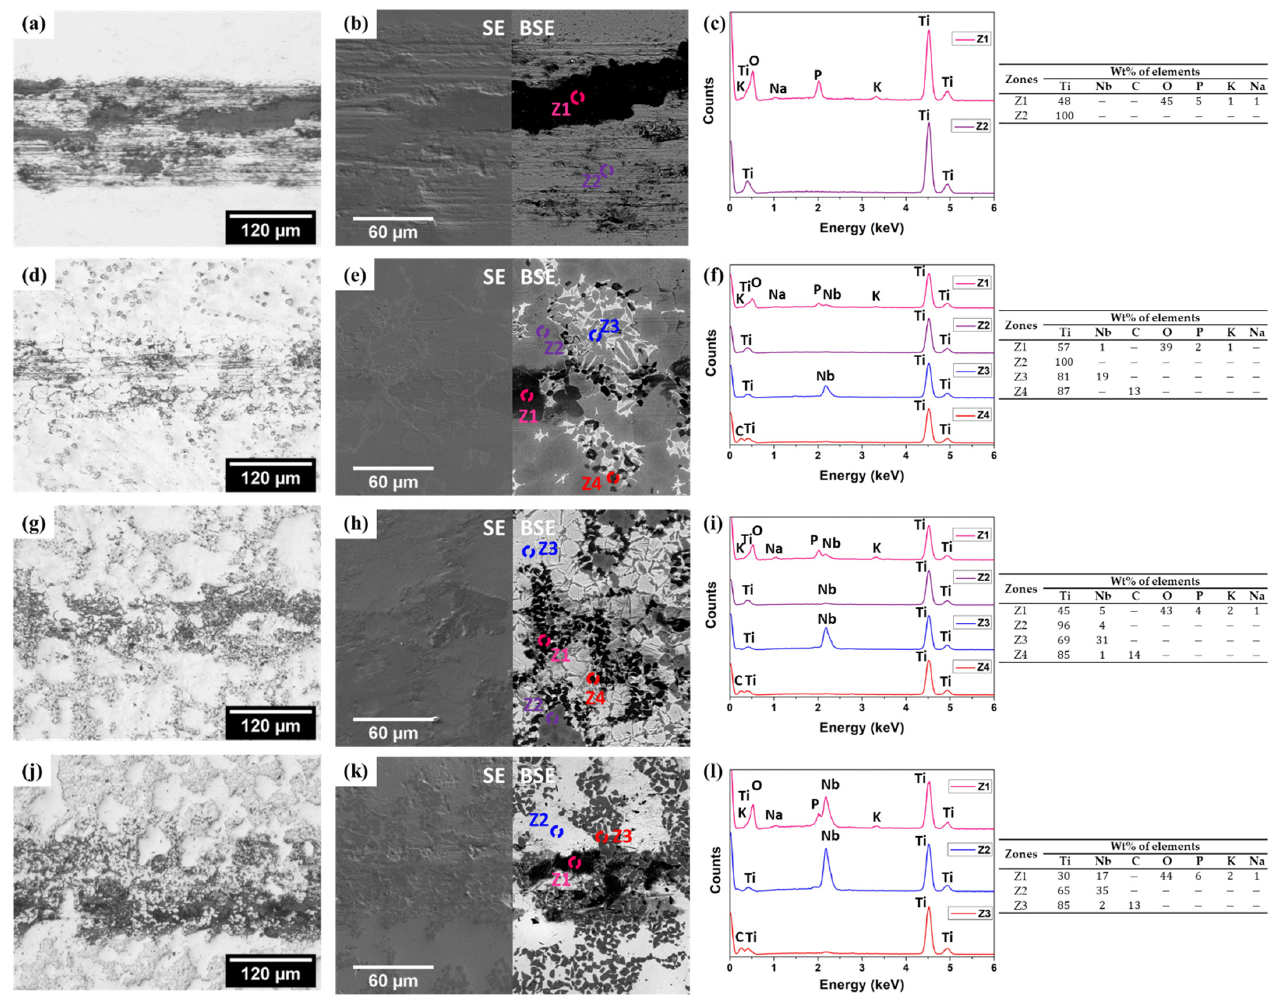
Figure 9. OM and SEM images together with EDS spectra of worn surfaces after tribocorrosion performed under anodic applied potential for: unreinforced Ti ( a – c ), Ti+5NbC ( d – f ), Ti+12.5NbC ( g – i ), and Ti+20NbC ( j – l ).